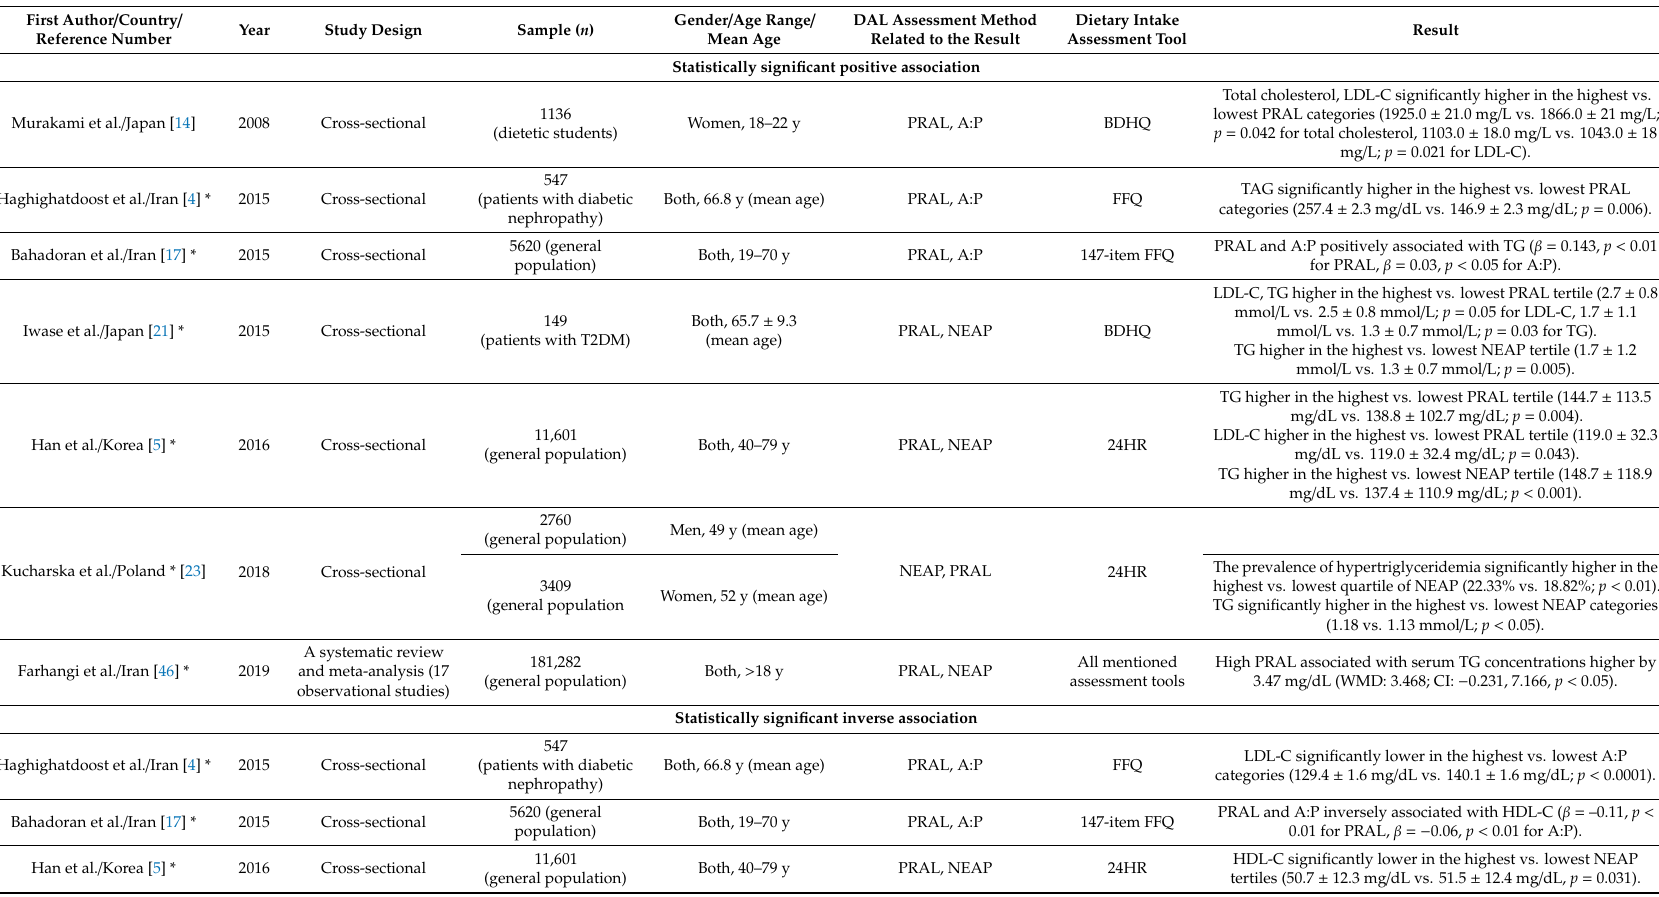
Table 3. Characteristics of studies referring to the association between DAL, triacylglycerol (TAG), low-density lipoprotein (LDL-C), high-density lipoprotein (HDL-C), total cholesterol, triglyceride (TG)